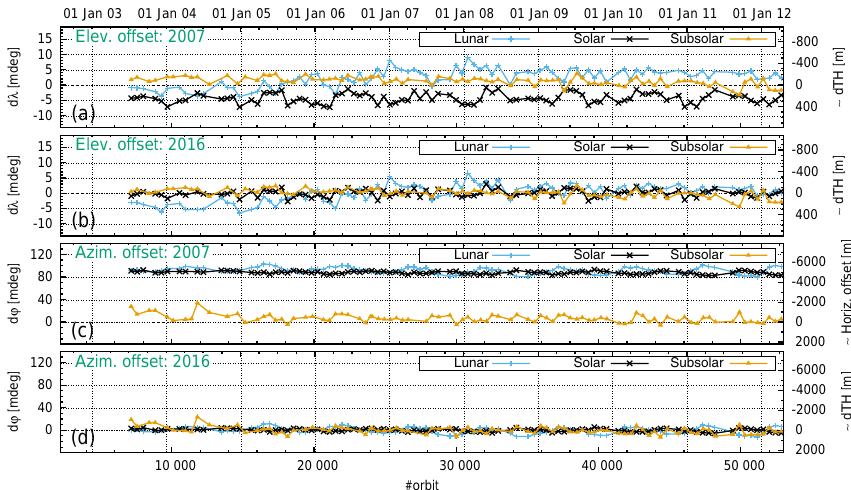
Figure 9. The elevation/azimuth angle offsets ( dλ / dϕ ) for the measurements used in the fit of the new mispointing parameters. (a, b) The elevation angle offset using the mispointing parameters from 2007 and the newly fitted parameters (2016). (c, d) The azimuth angle offset for both cases. With the new parameters, the offsets are strongly reduced.